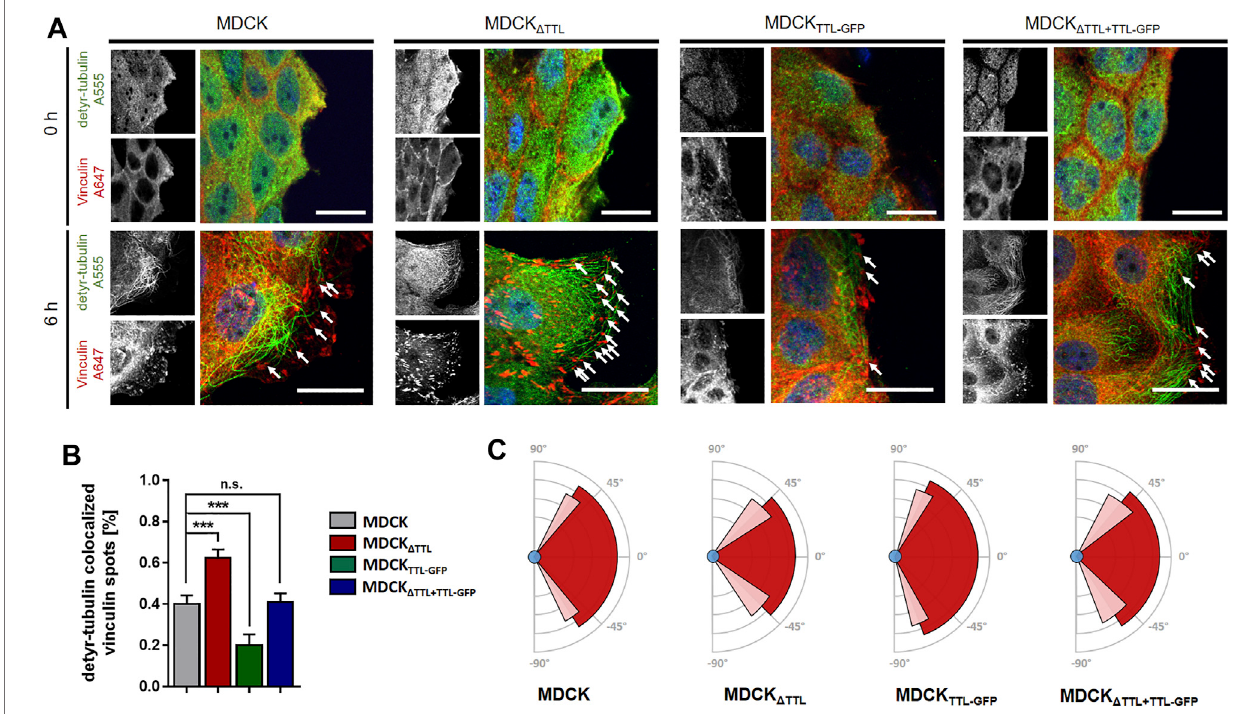
FIGURE 1 | Immuno fl uorescent staining of detyr-tubulin and vinculin after varying times of monolayer scratching. (A) Immuno fl uorescent staining of detyr-tubulin and vinculin after 0 and 6 h of monolayer scratching. Scratch-induced migration was initiated in con fl uent monolayers of MDCK, MDCK Δ TTL, MDCK TTL-GFP , and MDCK Δ TTL+TTL-GFP 0and6 hprior fi xationandpermeabilization.CellswerestainedforfocaladhesionsusingmAbanti-vinculin(AlexaFluor647,red)andforvisualization of microtubules using pAb anti-detyr-tubulin (Alexa Fluor 555, green). Arrows indicate proximity of detyr-tubulin and vinculin. Scale bars: 20 μ m. (B) Quanti fi cation of detyr-tubulin colocalized vinculin spots after 6 h of migration. Relative amount of colocalized spots at leading edges in MDCK, MDCK Δ TTL, MDCKTTL – GFP, and MDCK Δ TTL + TTL – GFP cells. Mean ± s.d., n = 3 independent experiments per cell line. Statistical signi fi cance was tested using one-way ANOVA with Dunnet ’ s comparison (n.s., not signi fi cant; *** p < 0.001). (C) Schematic diagram showing the average angle of focal adhesion placement after 6 h of cell migration in MDCK, MDCK Δ TTL, MDCKTTL – GFP, and MDCK Δ TTL + TTL – GFP cells. Average angles are indicated by dark-red area, SD is depicted in light-red. Angles were measured by ImageJ. Mean ± s.d., n = 3 independent experiments per cell line. A total of 10 – 15 cells were analyzed per experiment.